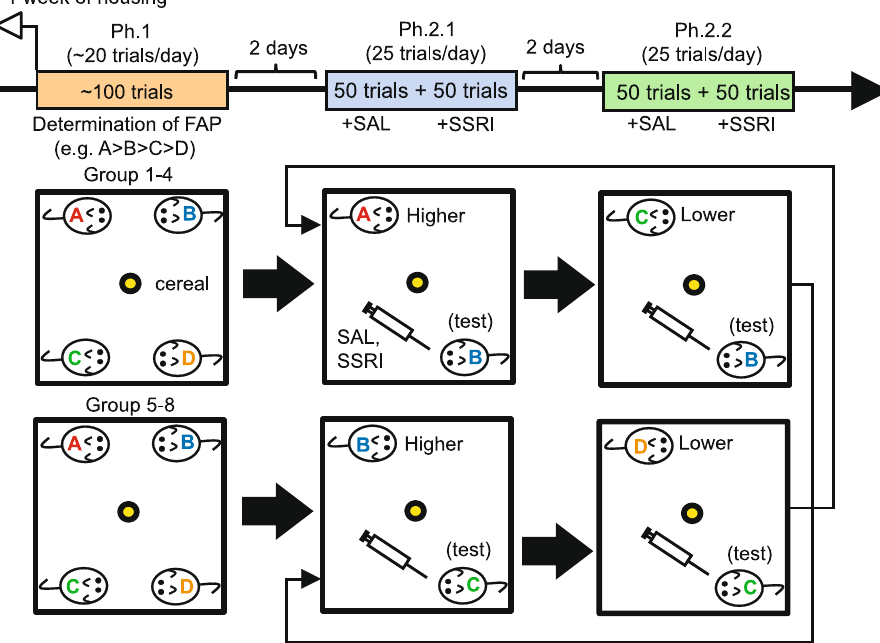
Figure 1. The behavioral test for decision-making under conflict associated with social obedience. Schematic diagrams illustrating the experimental design. Arrows indicate the sequence of experiments, beginning from Ph.1 to Ph.2.1 and Ph.2.2, followed by another set of Ph.2.1 and